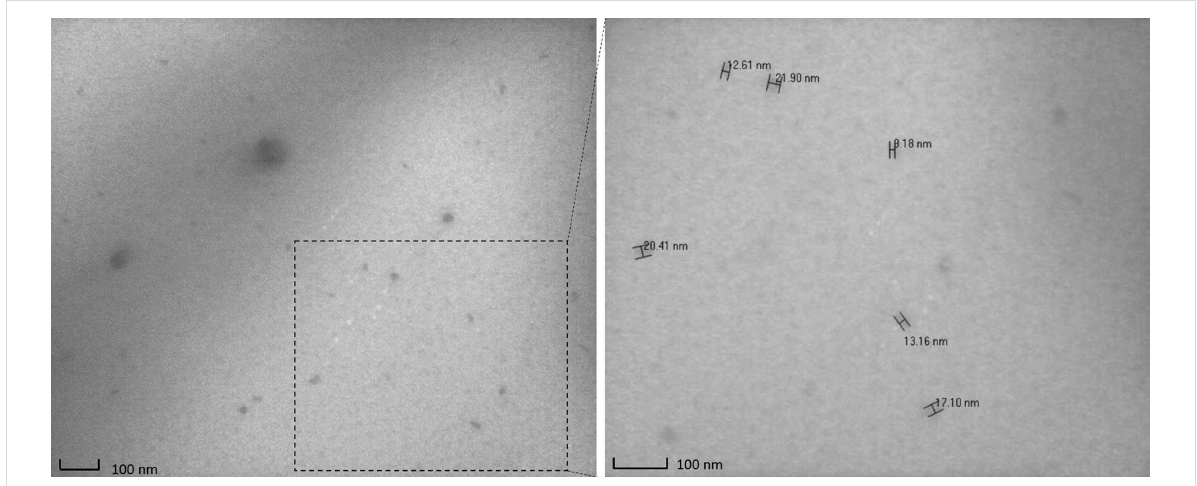
Figure 4: TEM images of A4-PEG 8 -PCL 2 10 mg/mL in water; size distribution is dominated by small nanoparticles (diameter ≤ 20 nm).